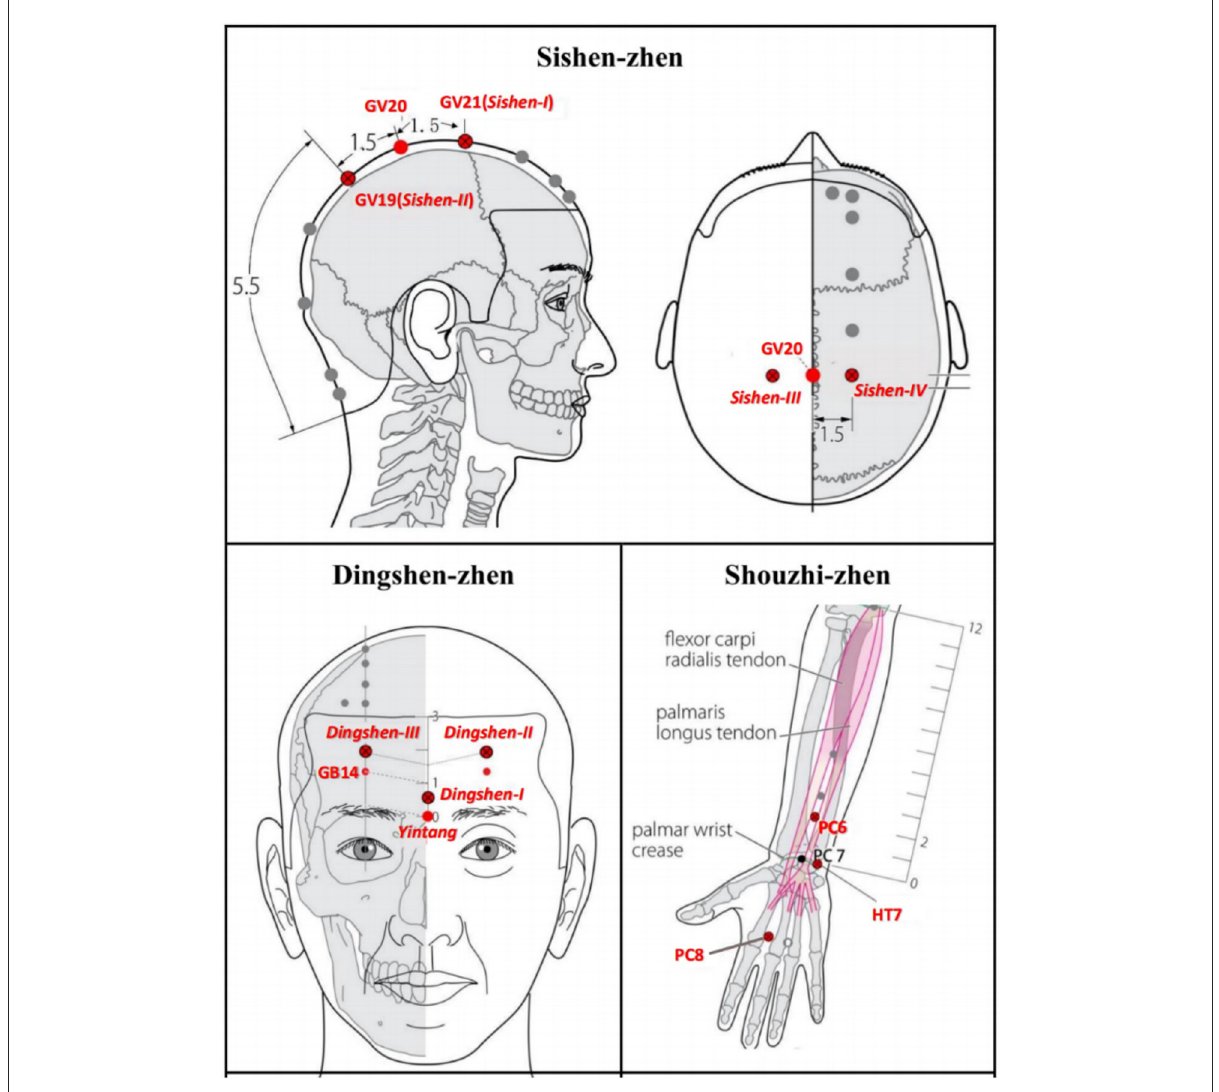
FIGURE2 JTN acupoint groups (Sishen-zhen, Dingshen-zhen, and